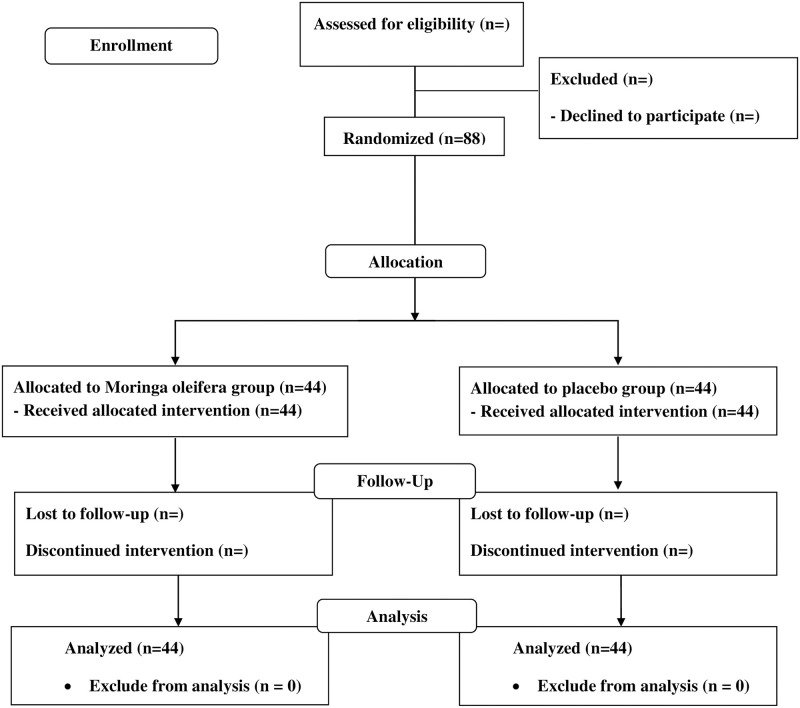
CONSORT flowchart.